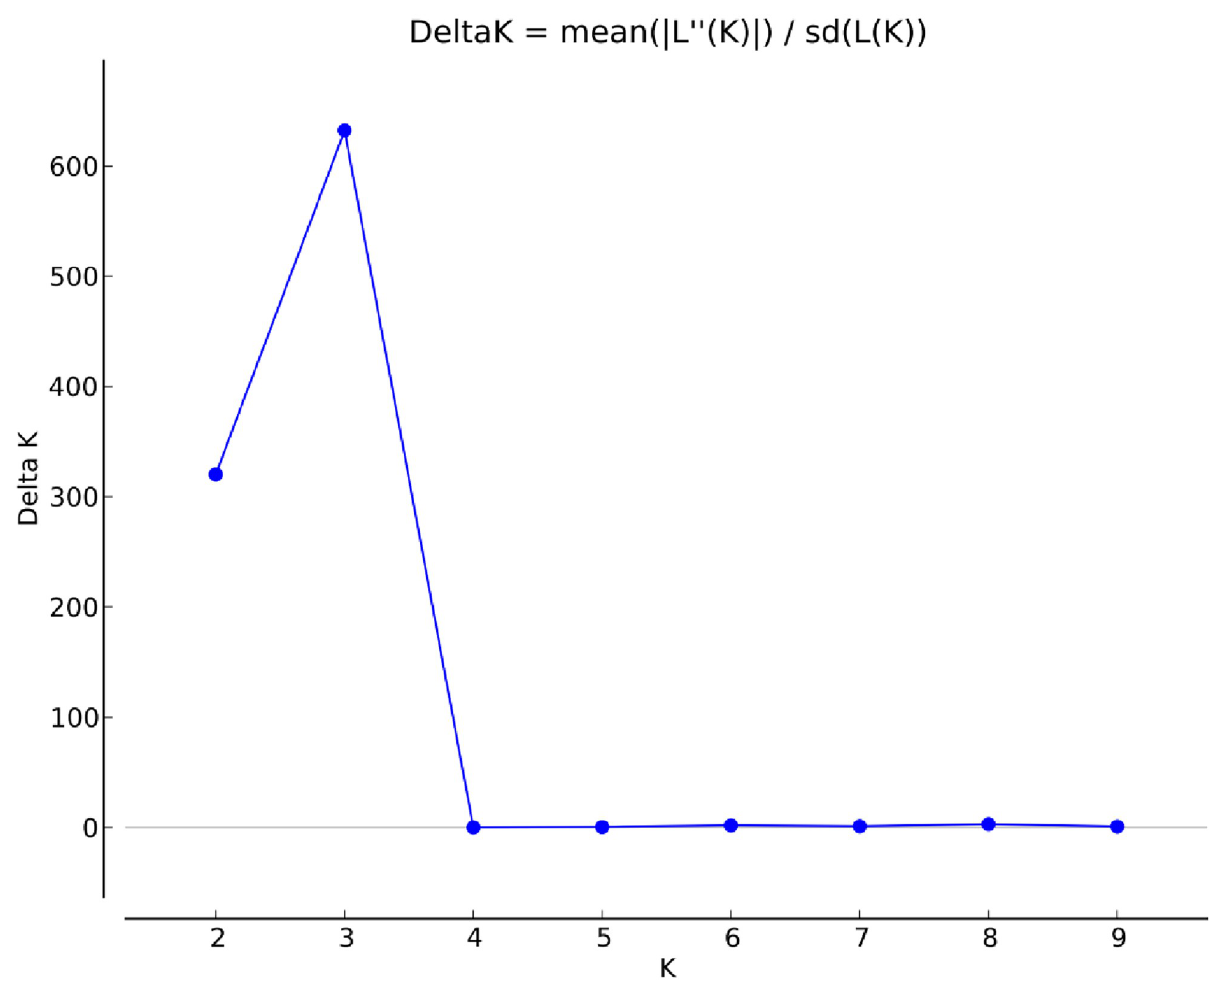
Fig 1. Determinations of subpopulations (K) of P . armeniaca var. ansu population.